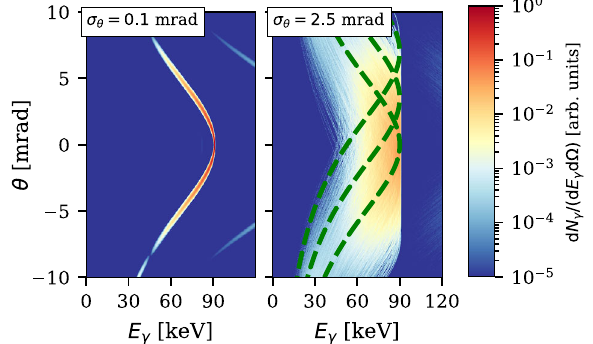
FIG. 5. Divergence effect on the spectrum. Number of photons emitted into observation angle θ at energy E γ by a mono- energetic electron bunch with negligible (left) and 2.5 mrad divergence (right). With increased divergence, single-electron emissions are shifted in θ . This is displayed exemplarily for three different electrons as dashed green